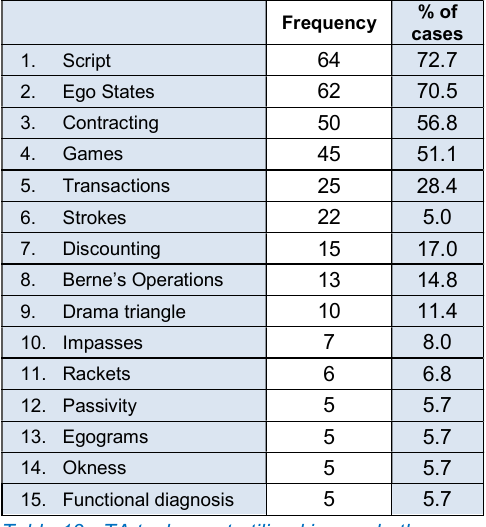
Table 13 - TA tools most utilised in